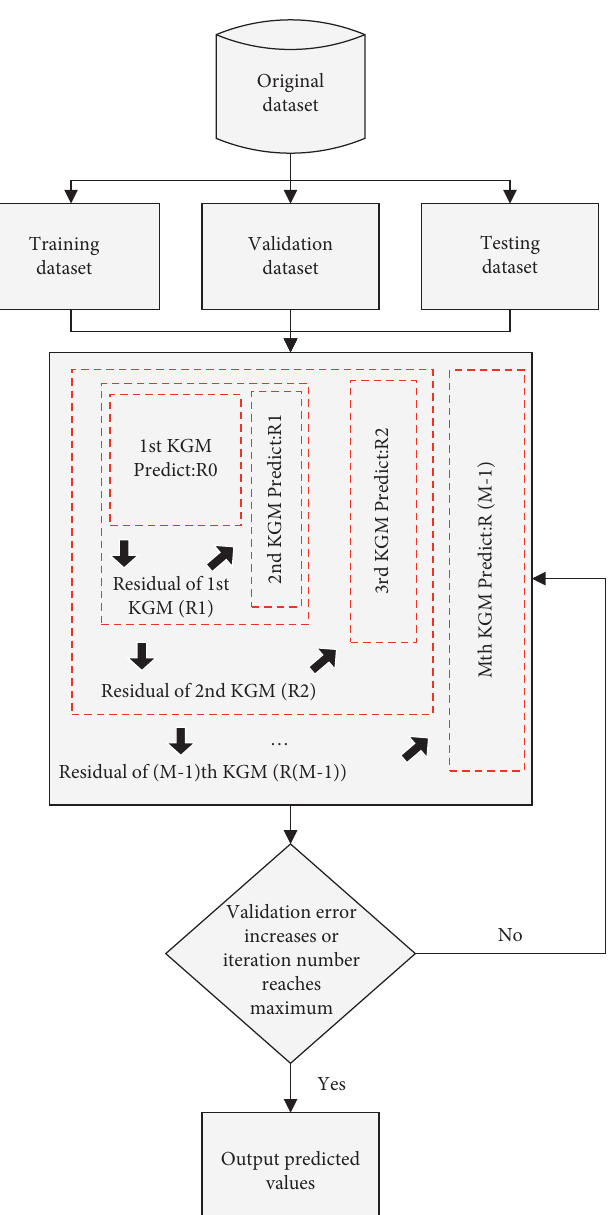
Figure 1: The scheme of an ensemble learning method with least squares boosting algorithm for KGM (1,